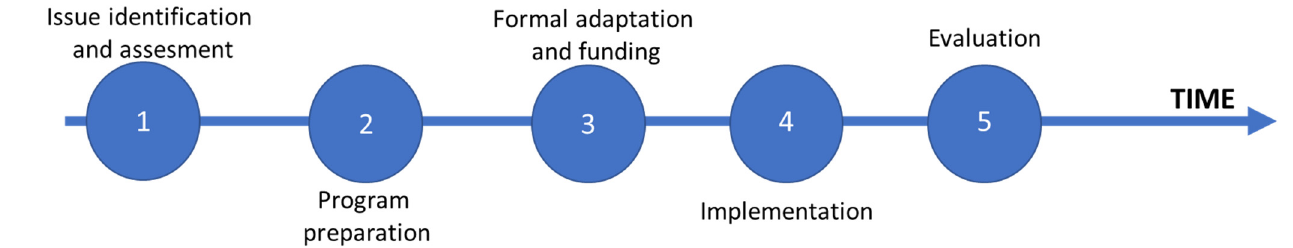
Figure 2. The conventional approach to integrated coastal management systems.